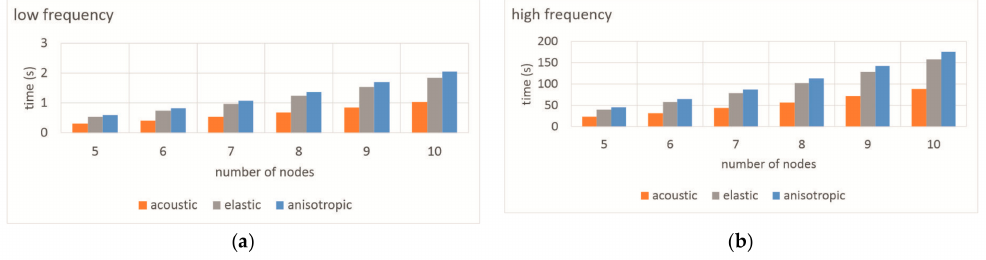
Figure 14. The execution time computed for di ff erent numbers of nodes per wavelength for: low ( a ) and high ( b ) frequencies of the source wavelet.